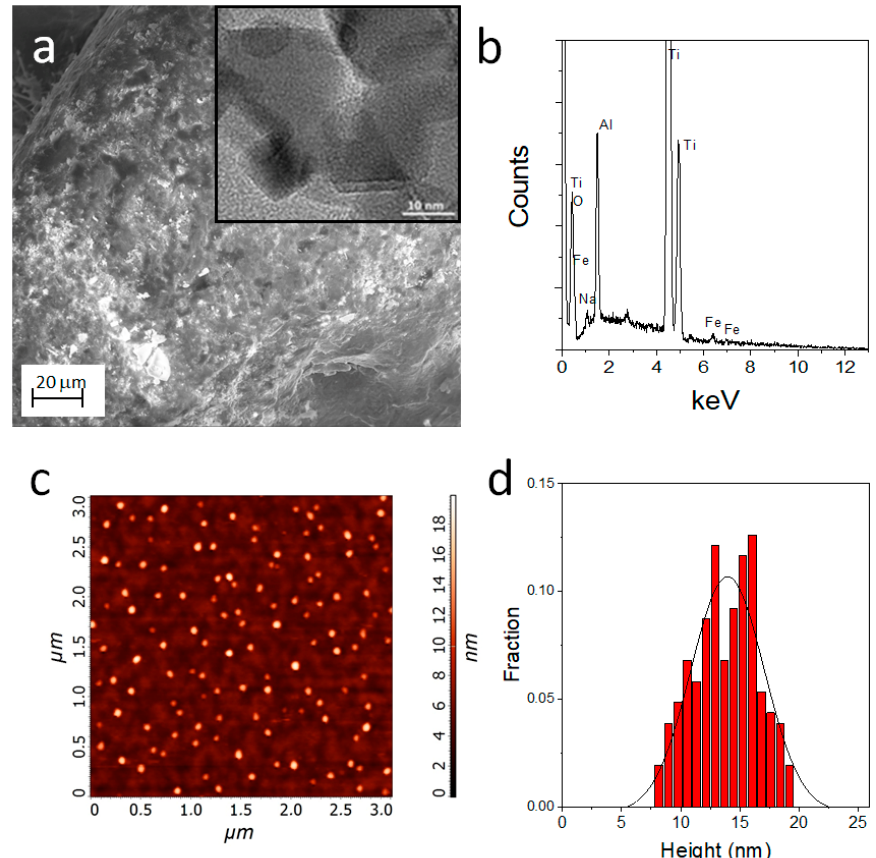
Figure 3. ( a ) Representative SEM image of Ti_ γ Fe 2 O 3 scaffolds; Insert TEM image for Ti_ γ Fe 2 O 3 ; ( b ) EDX data of Ti_ γ Fe 2 O 3 ; ( c ) AFM images of γ Fe 2 O 3 NPs on flat Si(100); ( d ) statistical analysis performed on an area of 5 µ m × 5 µ m of the observed feature heights.